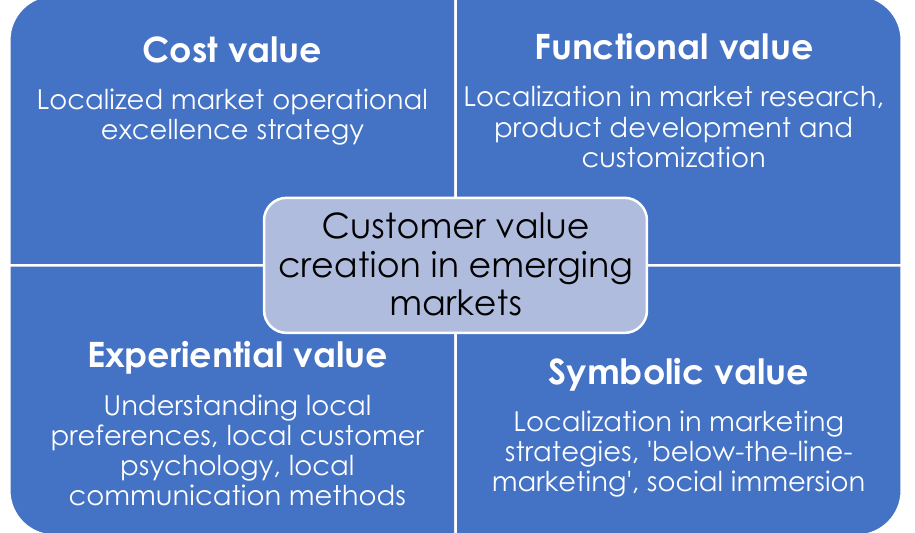
Figure 1. Customer value creation in emerging markets .